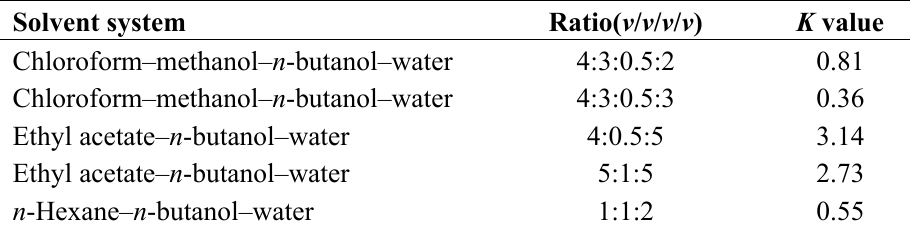
Table 3. The partition coefficients ( K ) of the poncirin in different solvent systems of HSCCC. The K value was defined as the peak area of the compound in the upper phase divided by that in the lower